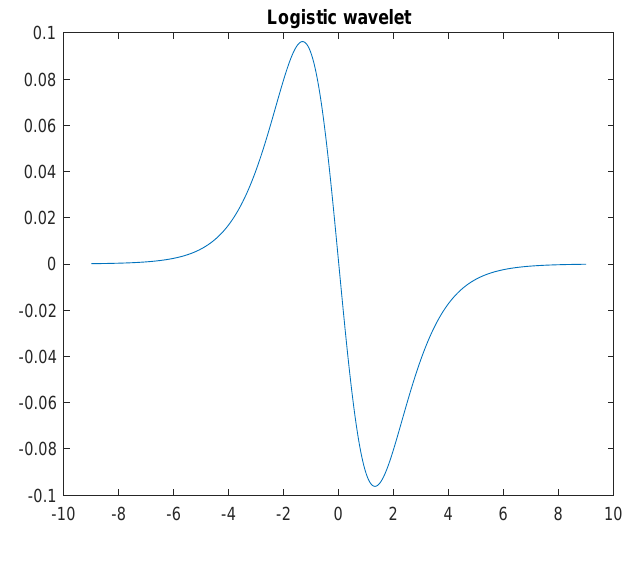
Figure 1. Wavelet ψ 2 ( x )